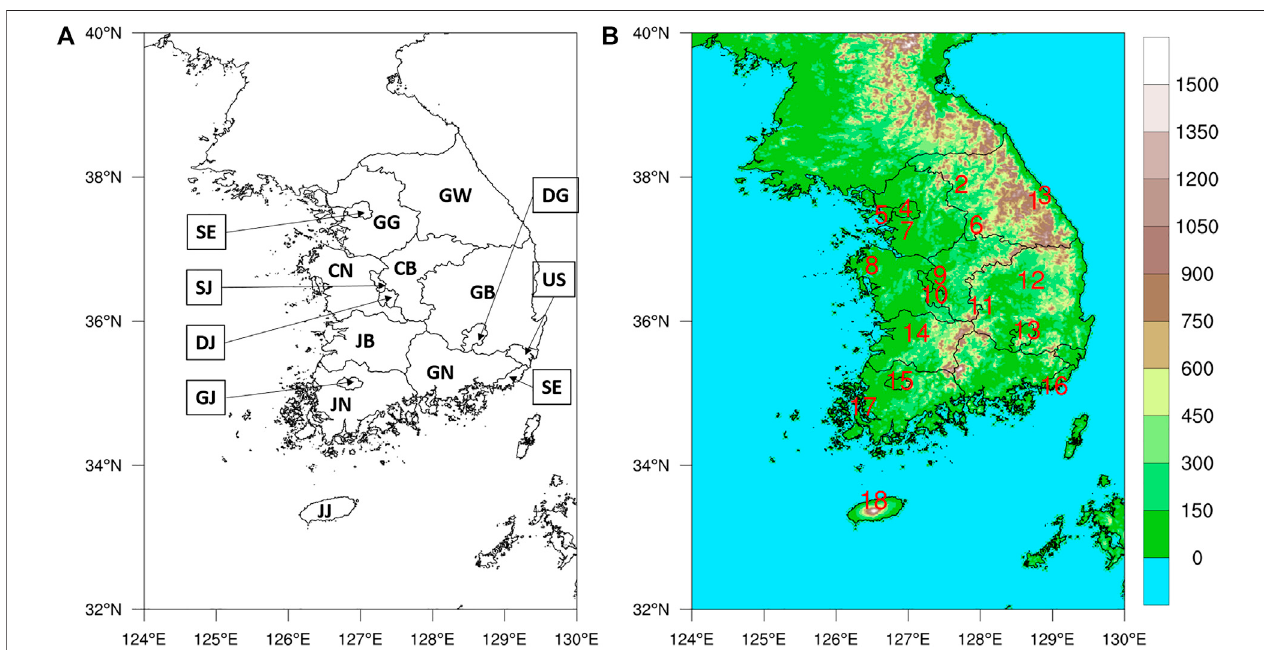
FIGURE 1 | Administrative division in Korea (A) and Topography (B) in the UASIBS – KIER model domain.